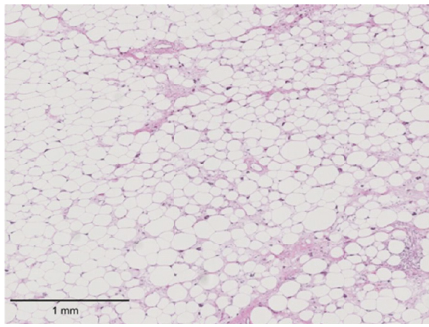
Figure 3: Pathological findings show mature adipocytes with cel- lular atypia and marked variations in size and shape. Hematoxylin- eosin staining, × 25. Scale bar,